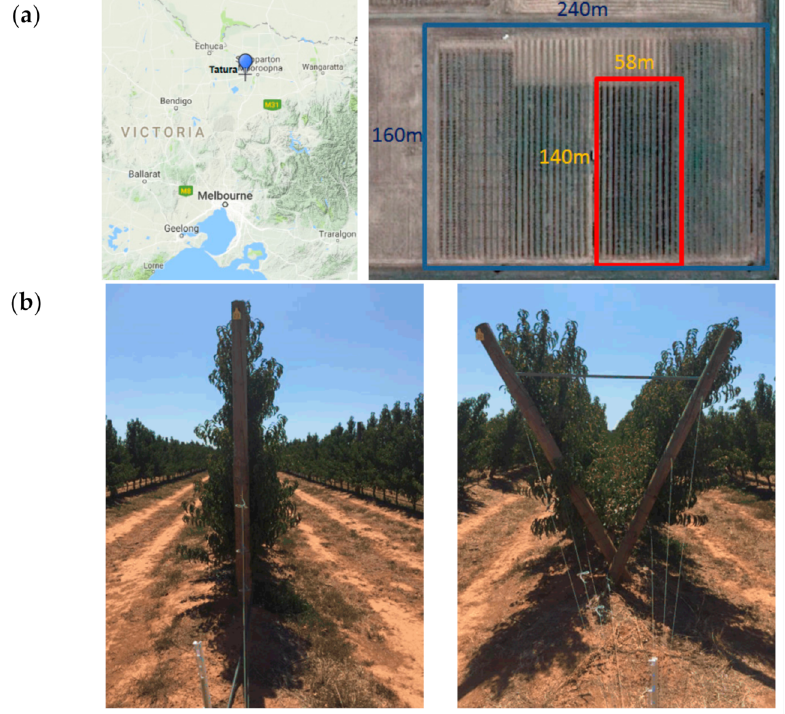
Figure 1. ( a ) Location of the study site; Stonefruit Experimental Orchard (Tatura, Victoria. Australia). Image source from Google Maps. ( b ) Canopy structures in vertical leader ( left ) and Tatura trellis ( right ). Photos taken midseason (January 2017) at midday (solar noon) looking in a north